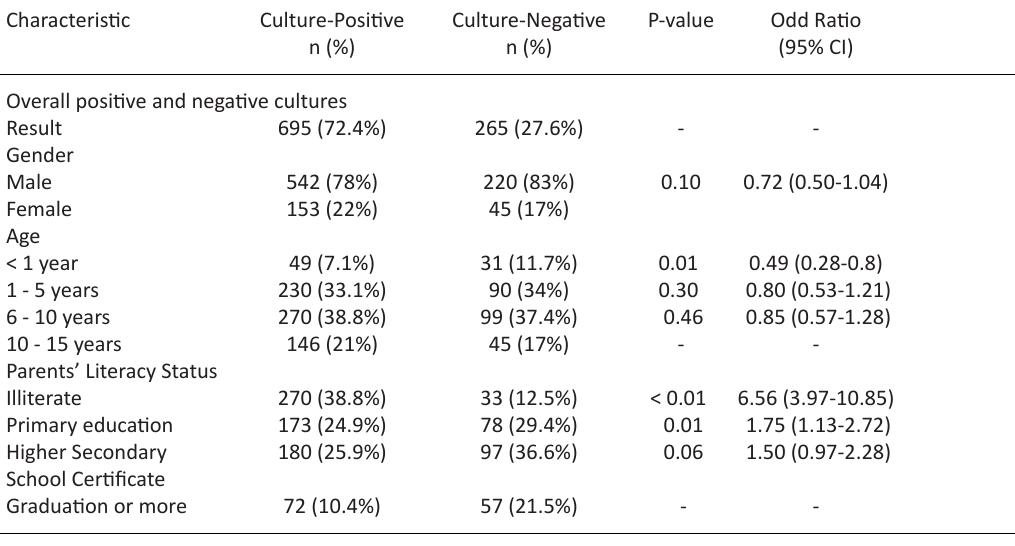
Table 1. Demographic factors of enrolled cases of pediatric wound infections (n = 960) Characteristic Culture-Positive